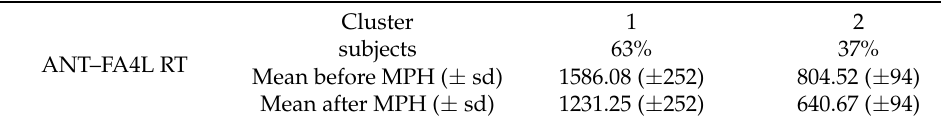
Table 4. Cluster characteristics in neuropsychological